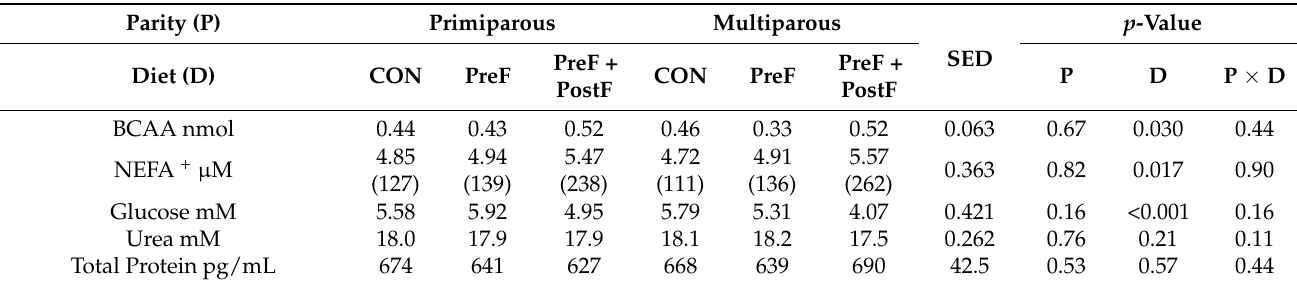
Total Protein pg/mL